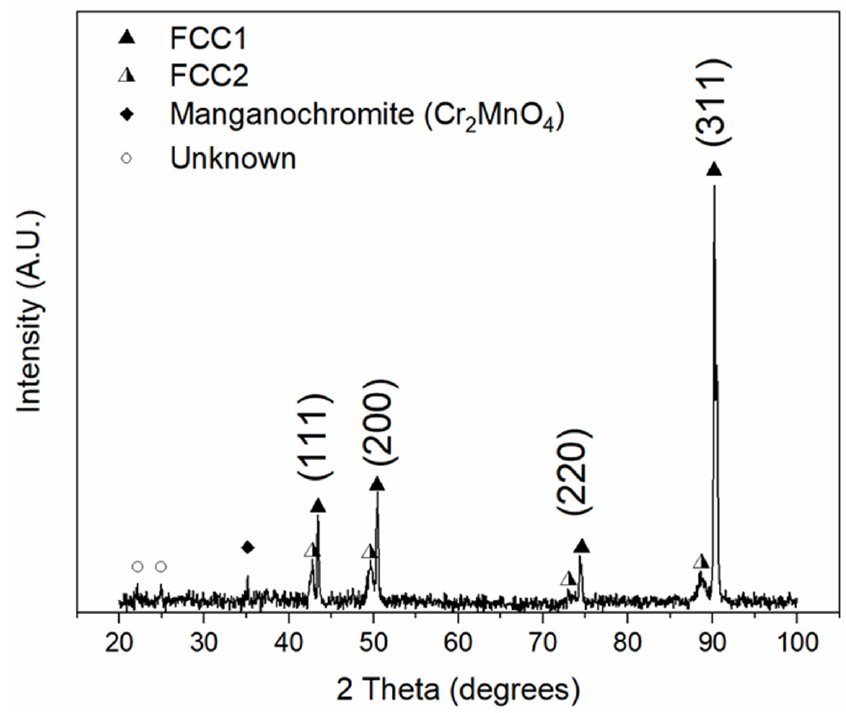
Figure 4. XRD pattern of equiatomic CrMnFeCoNiCu after 30% rolling reduction and annealing at Figure 4. XRD pa tt ern of equiatomic CrMnFeCoNiCu after 30% rolling reduction and annealing at 1200 ◦ C for 48 h. 1200 °C for 48 h.